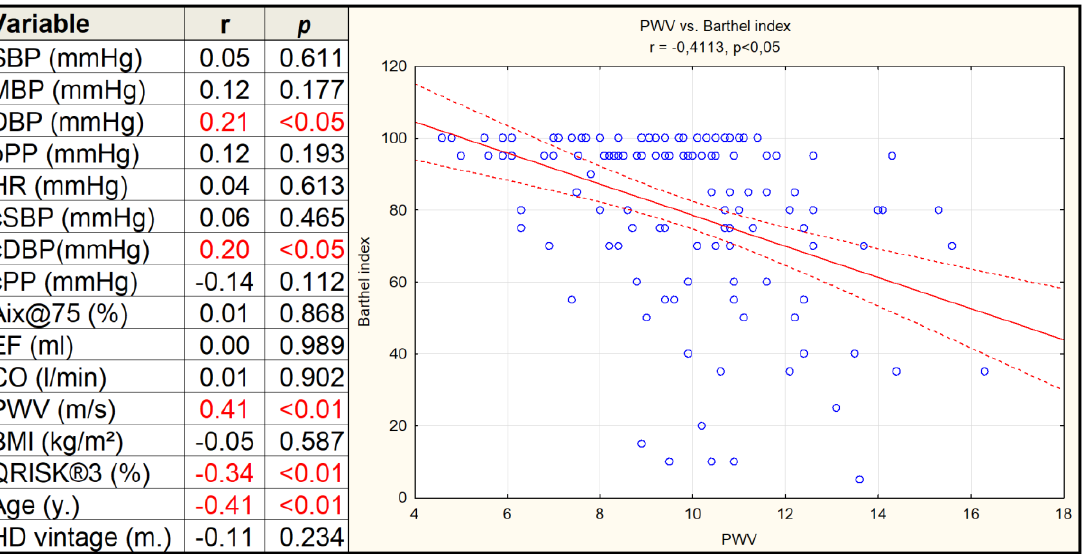
dependent and independent group. Table 3. Disorders leading to disability.